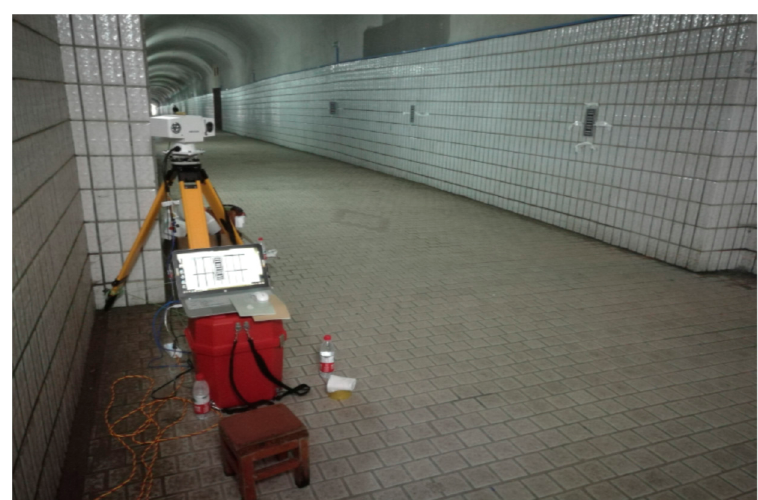
Figure 12. The leveling measurement field in a tunnel using close-range photogrammetry.